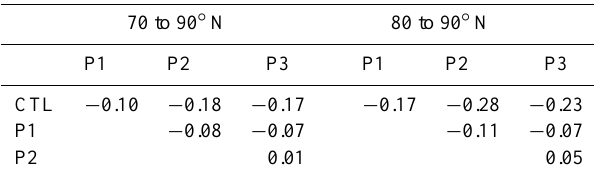
Table 5. Difference matrix (inWm − 2 ) for the JJA averaged aerosol direct forcing (see Tables 3 and